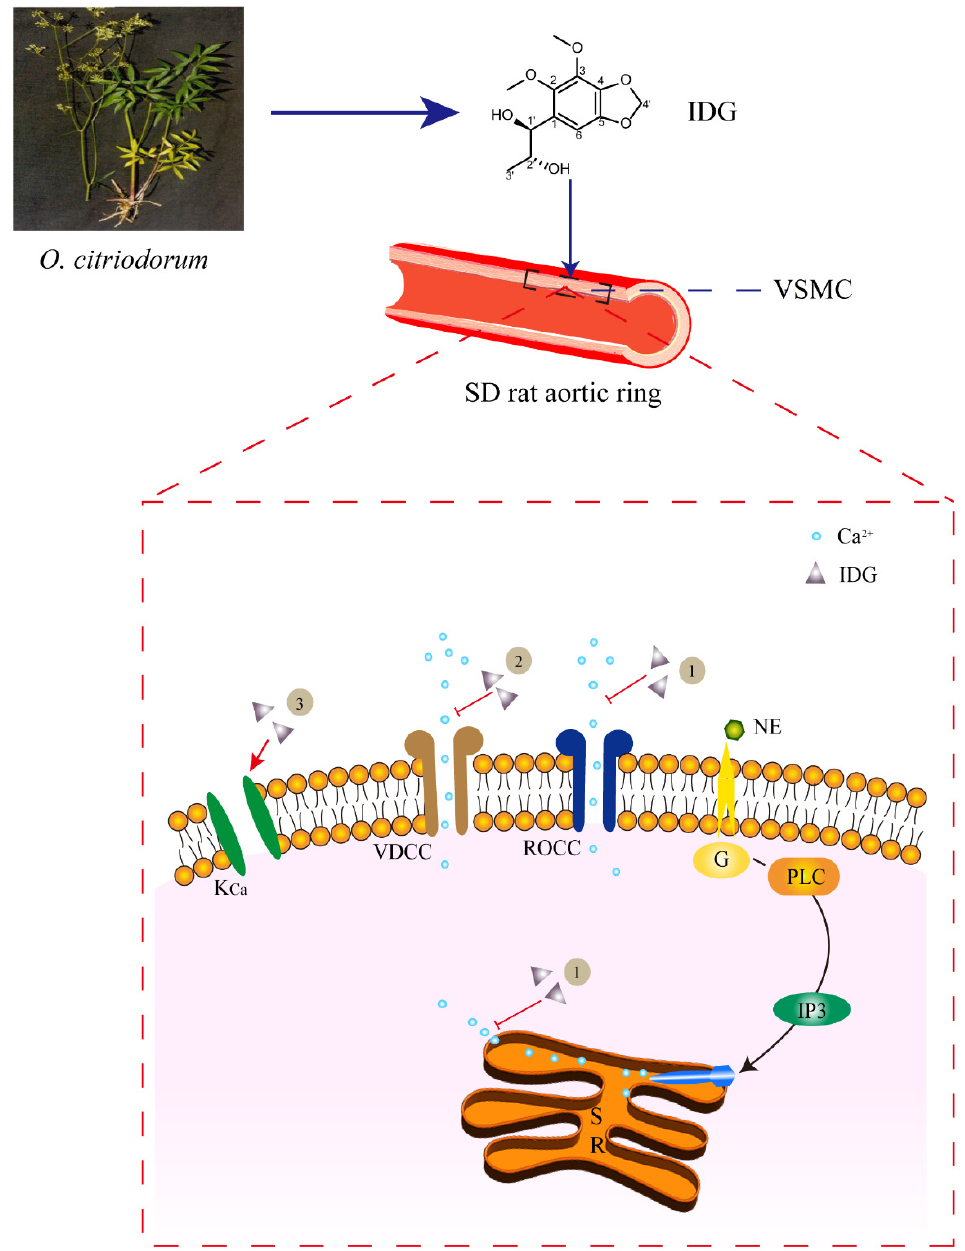
Figure 9. The role of IDG in relaxing vascular smooth muscle cells could be related to the following pathways: ( 1 ) the vasorelaxant e ff ects of IDG caused by inhibiting extracellular Ca 2 + influx and pathways: ( 1 ) the vasorelaxant effects of IDG caused by inhibiting extracellular Ca 2+ influx and intracellular Ca 2 + release through the receptor-operated Ca 2 + channel (ROCC); ( 2 ) IDG-inhibited intracellular Ca 2+ release through the receptor-operated Ca 2+ channel (ROCC); ( 2 ) IDG-inhibited extracellular Ca 2 + influx through the voltage-dependent Ca 2 + channel (VDCC); ( 3 ) IDG may activate extracellular Ca 2+ influx through the voltage-dependent Ca 2+ channel (VDCC); ( 3 ) IDG may activate the K Ca the K Ca channel.